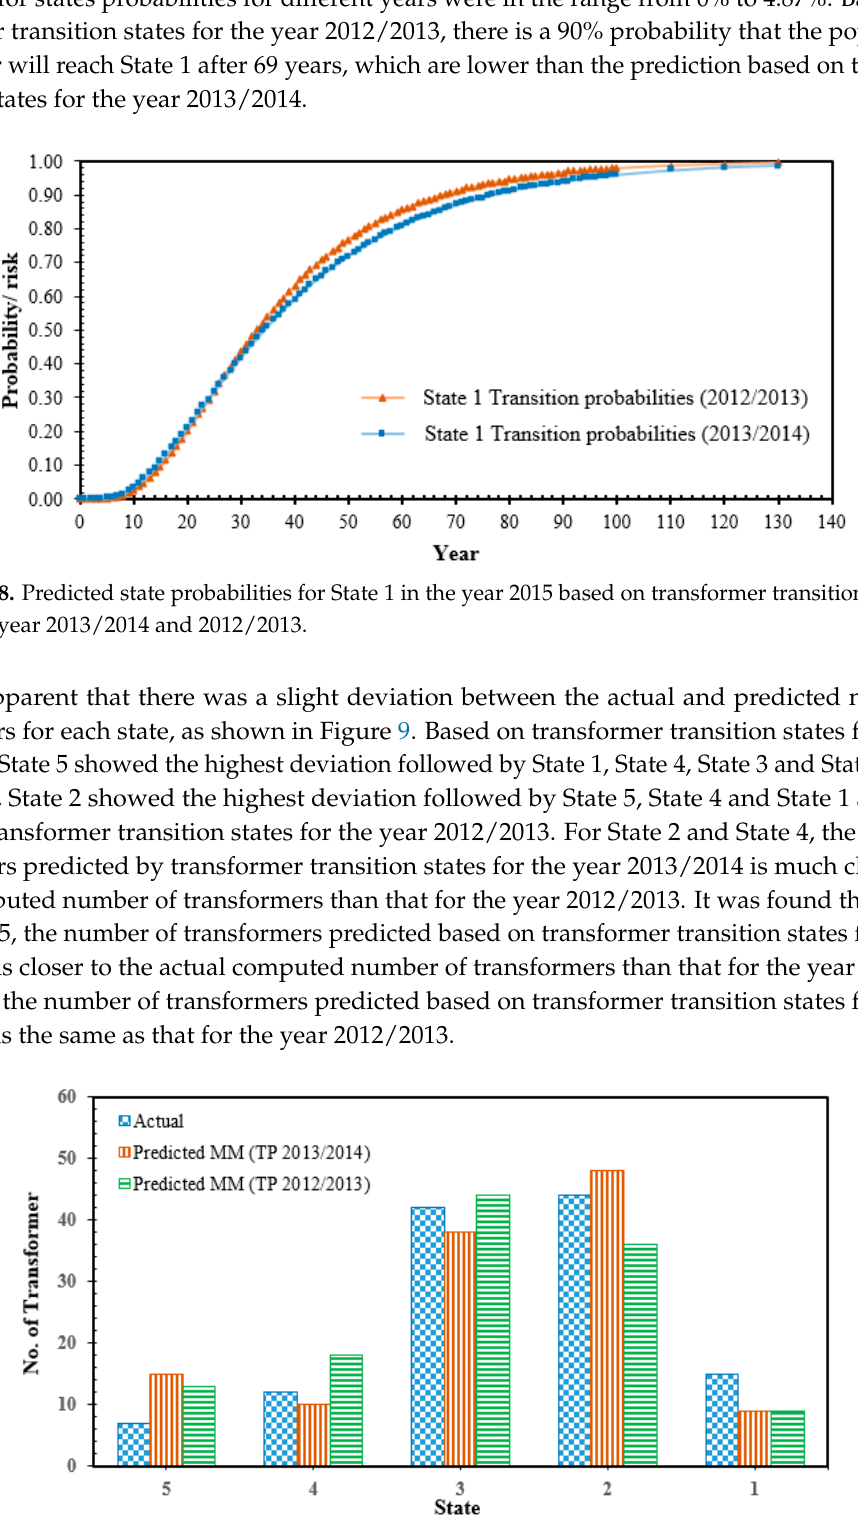
Figure 9. Actual and predicted transformer populations in the year 2015 based on transformer transition states for the year 2013/2014 and 2012/2013.